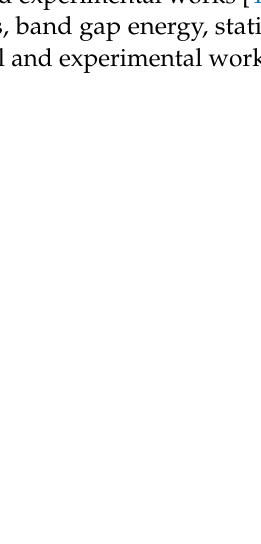
Figure 1. Schematic representation of Cu 2 ZnSnS 4 and Cu 2 ZnSnSe 4 in their kesterite structure.